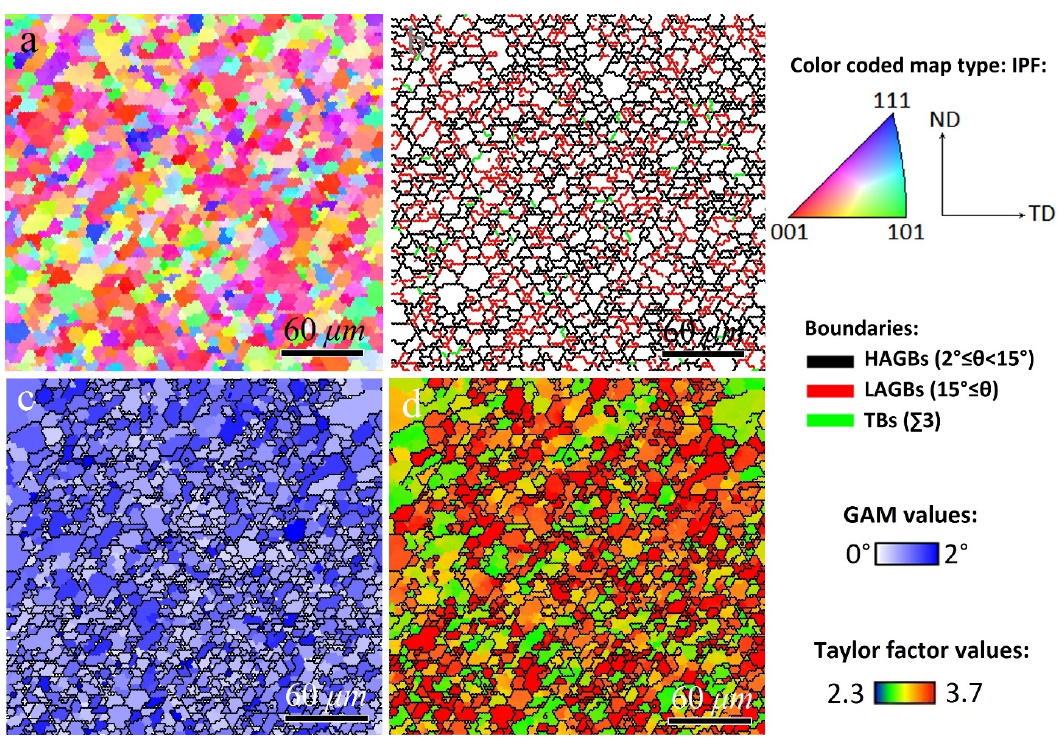
Figure 7. ( a ) IPF, ( b ) grain boundaries, ( c ) GAM, and ( d ) Taylor factor maps of the LH sample.